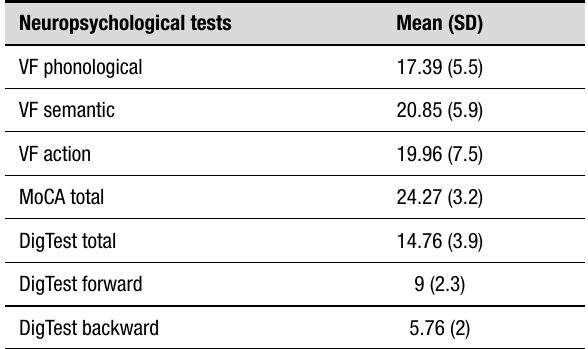
Table 1. Descriptive of three verbal fluency tasks, MoCA test, and Digit Span test